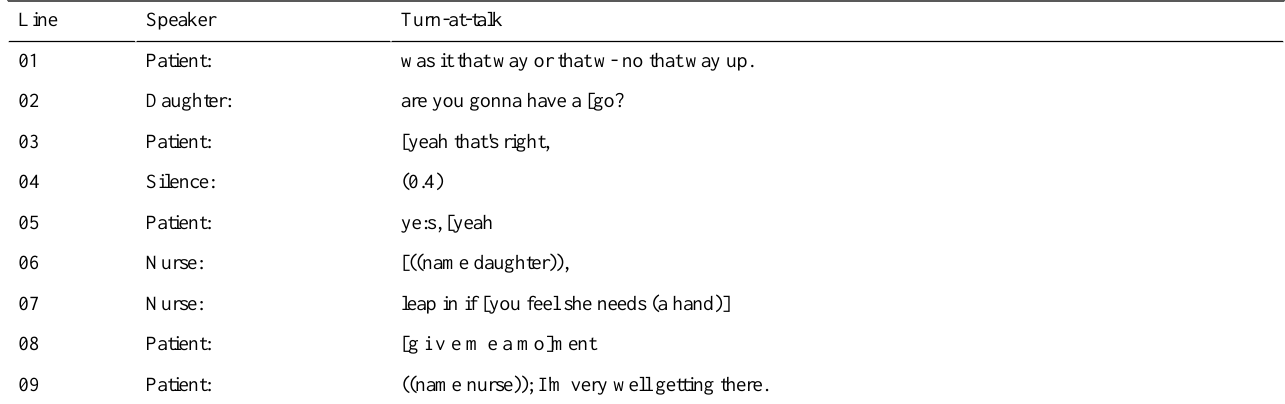
Table 3. Example of a patient resisting help from a relative during a video examination (data recorded at the patient end).